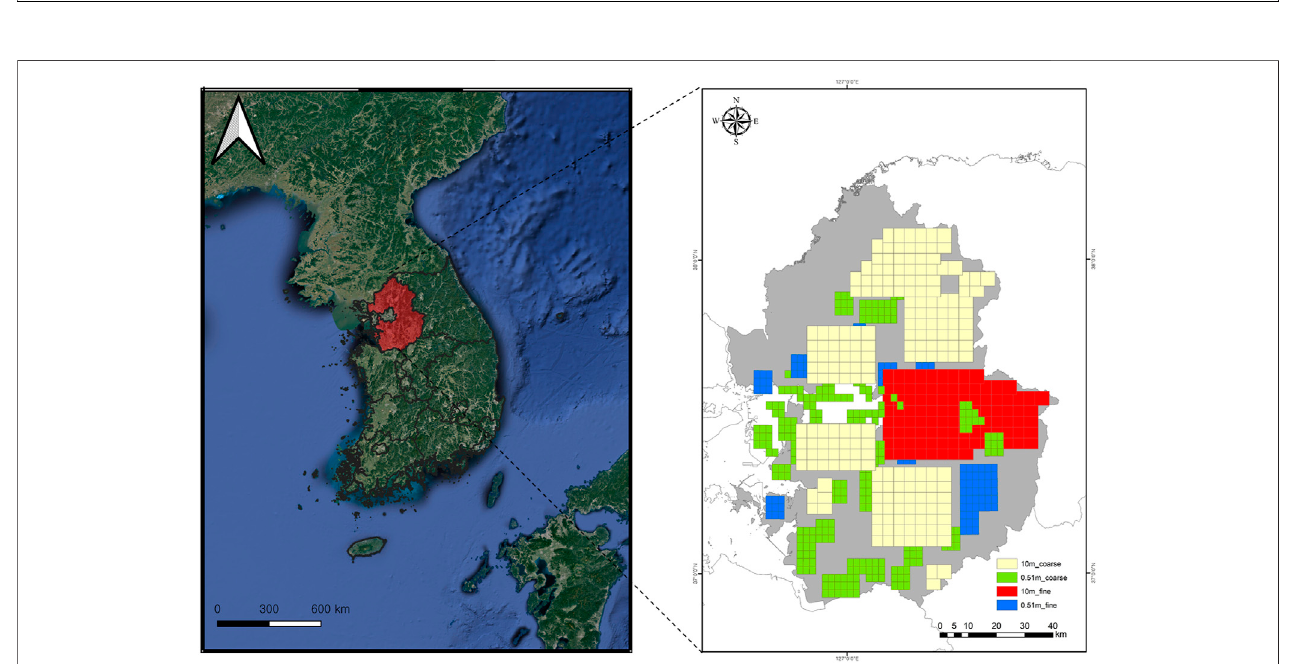
FIGURE 2 | Study area in this study.